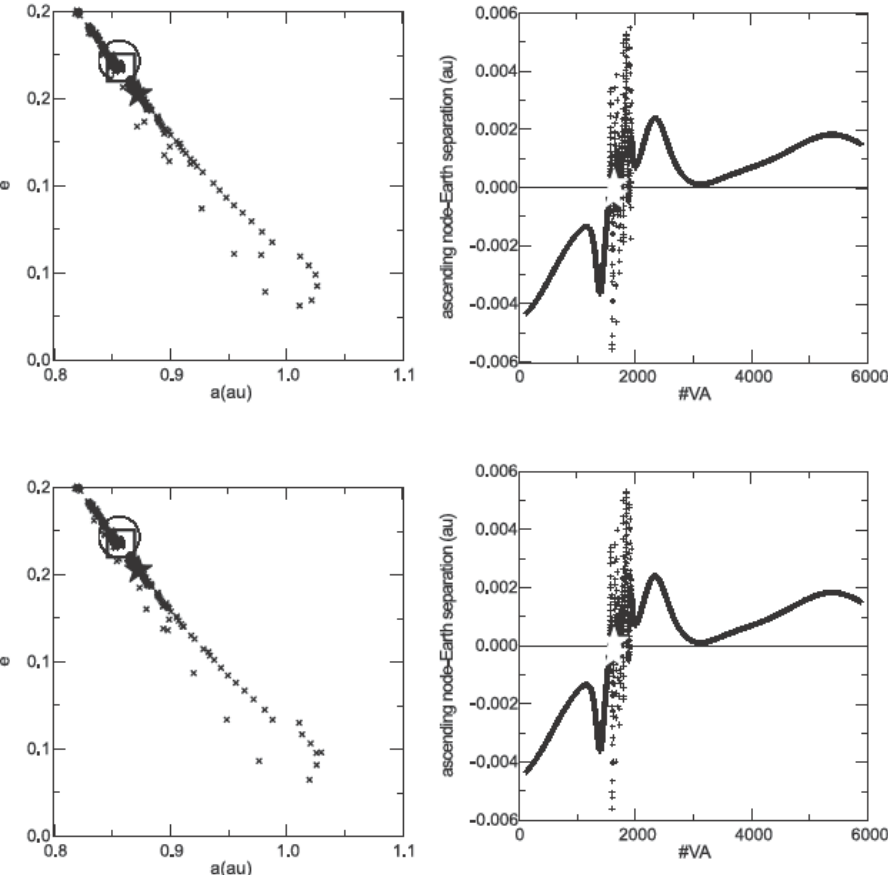
Figure 3. The LOV 1 method. Position of orbital elements of the asteroid 2001 BB16 computed for 5 sigma and for 3000 clones on both side on the LOV . These clones are computed with the non-gravitational parameter A 2 for 17 massive asteroids - top panels, and for 0 asteroids - bottom panels. Left panels - phase space of ( a , e ) on MJD122774.0 (JD2522774.5 = 2195-Jan-8) of 6001 VAs where circle - denotes initial position on MJD58200 (JD2458200.5=2018-March-23), square - nominal orbit on MJD122774.0 (JD2522774.5 = 2195-Jan-8), great star - position of VA #1632, which is close to impact orbit in 2195. Right panels - distance of ascending node of serial number of VAs of asteroid 2001 BB16 to the center of the Earth, at that same time as in the left panel, i.e. on MJD122774.0 (JD2522774.5 = 2195-Jan-8). Distances selected from subsequent clones (#1624 and #1635, from bottom to top), which are smallest among all VAs are marked by